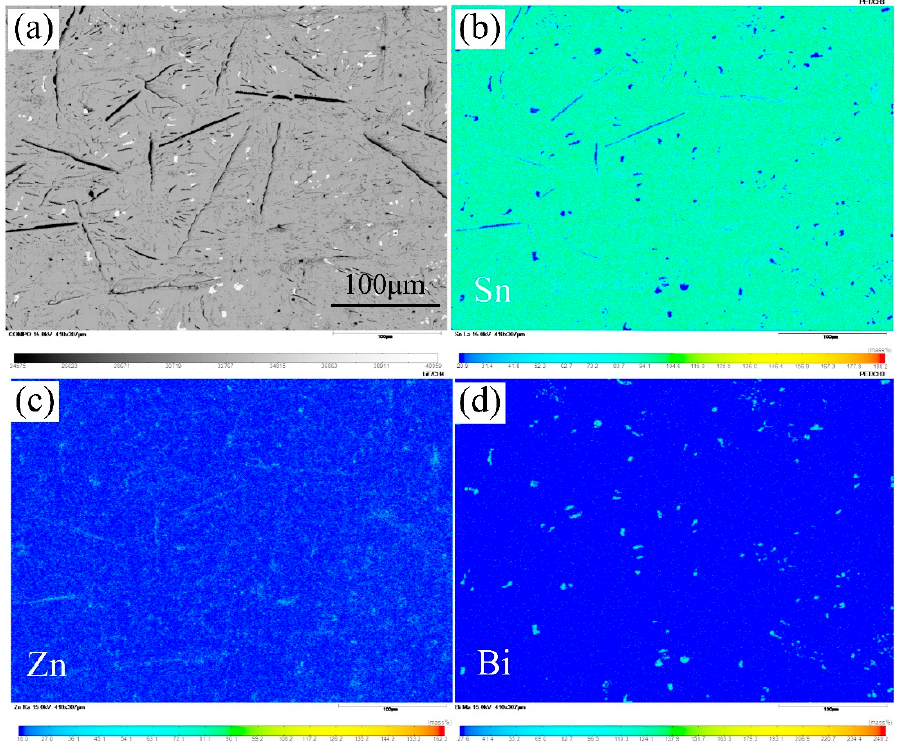
Figure 4. EPMA images and map analyses of the interface of Sn-9Zn-5Bi: ( a ) BSE images; ( b ) Sn element; ( c ) Zn element; ( d ) Bi element.